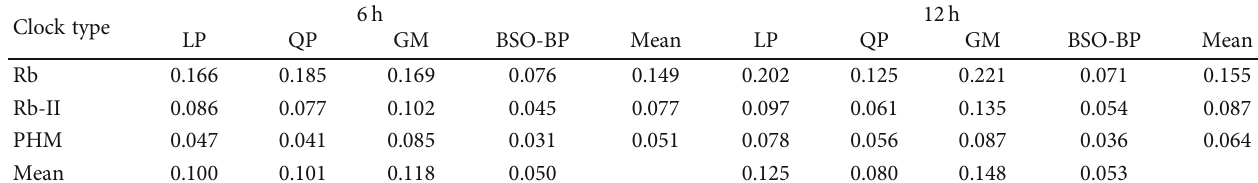
Table 4: The statistics of 1-hour average STD of four models based on 6-hour and 12-hour SCB data. Clock type